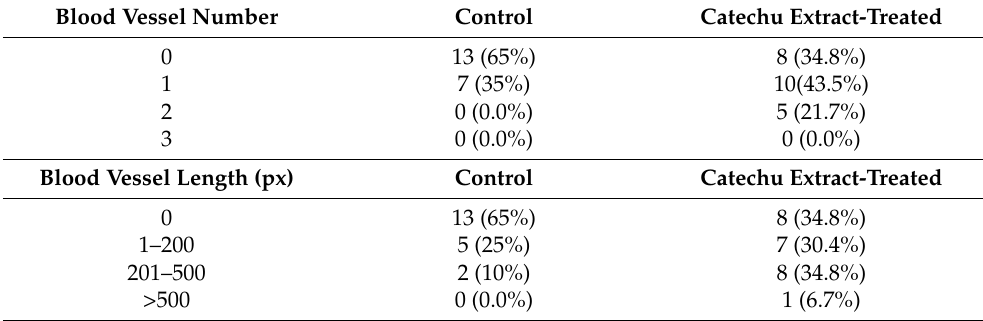
Figure 2. The pro- angiogenic effects on zebrafish embryos in the presence of 300 μg/mL catechu extracts. ( A ) Control, and ( B ) Catechu extract-treated. Red arrows indicate the formation of extra sprouts in the sub-intestinal veins of fish embryos. Sprout blood vessel number and blood vessel length are listed. About twenty embryos were used for each group. The measured blood vessel length unit (px) is defined using the software WenXin WximageView. Table 2. The pro-angiogenic effects on zebrafish embryos in the pre sence of 300 μg/mL catechu extracts. Blood vessel number and blood vessel length are listed. About twenty embryos were used for each group. The measured blood vessel length unit (px) is defined using the software Image J.